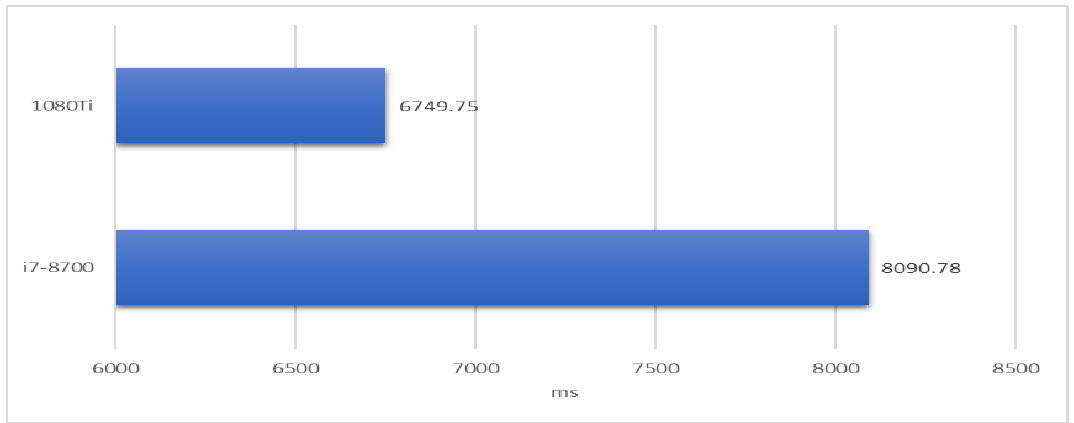
Figure 12. Cost of publishing a Masked Authenticated Message (MAM) transaction.